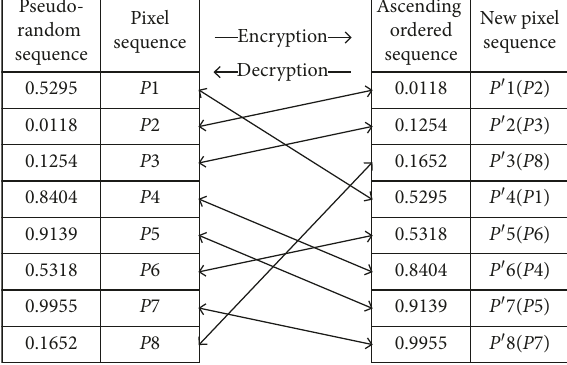
Figure 3: Scrambling process and its decryption process.